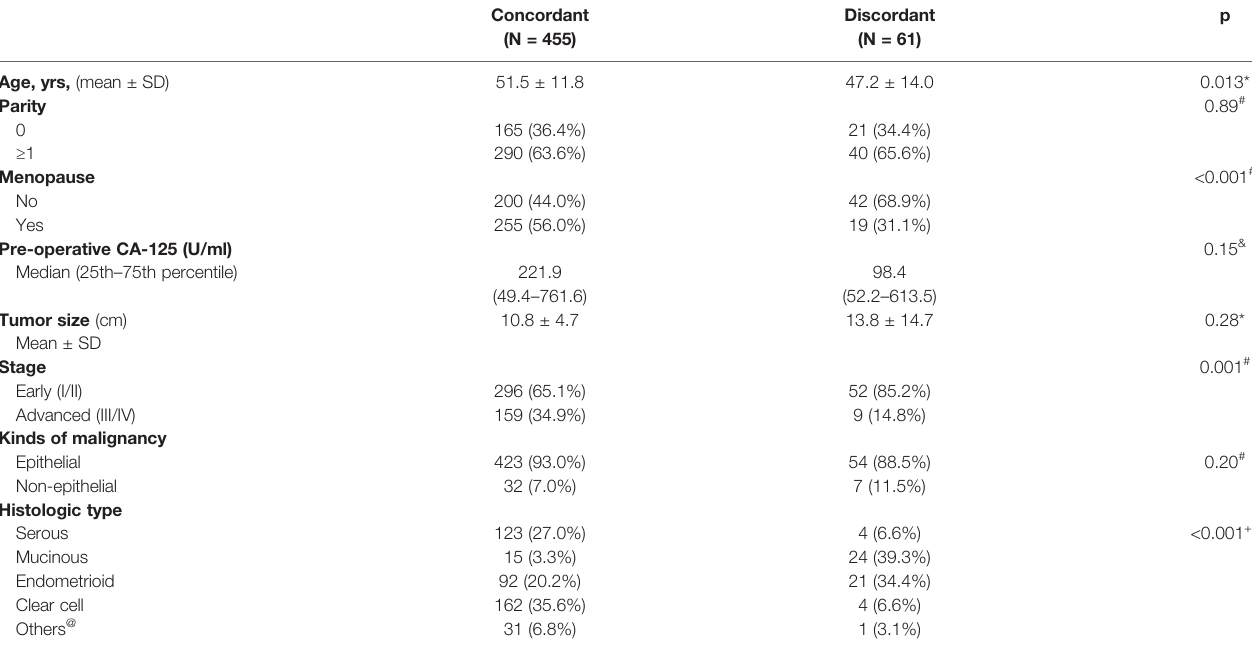
TABLE 5 | Patient demographics and clinical and histopathological characteristics of concordant and discordant intraoperative frozen and fi nal paraf fi n pathologies of 516 women and their malignant ovarian tumors.